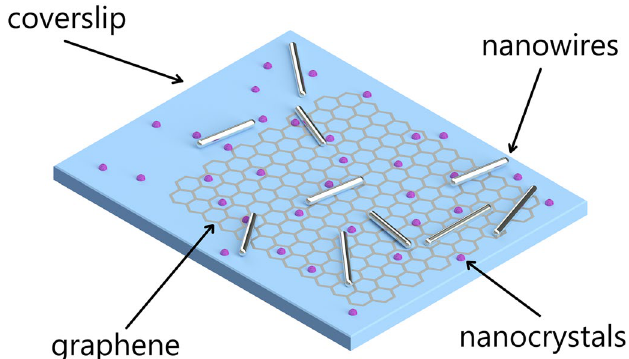
Figure 2. Illustratation of the examined sample (not to scale). Nanocrystals and silver nanowires deposited on graphene or glass are